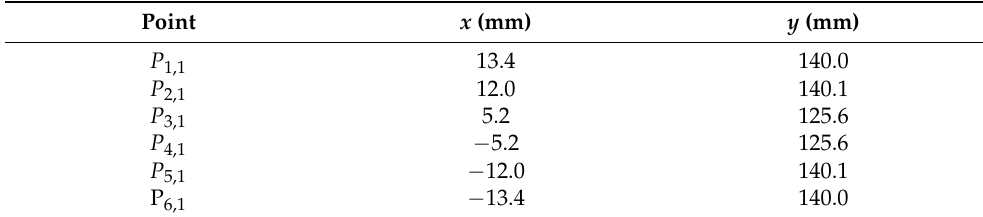
Table 1. Coordinates of the profile points of the first sprocket